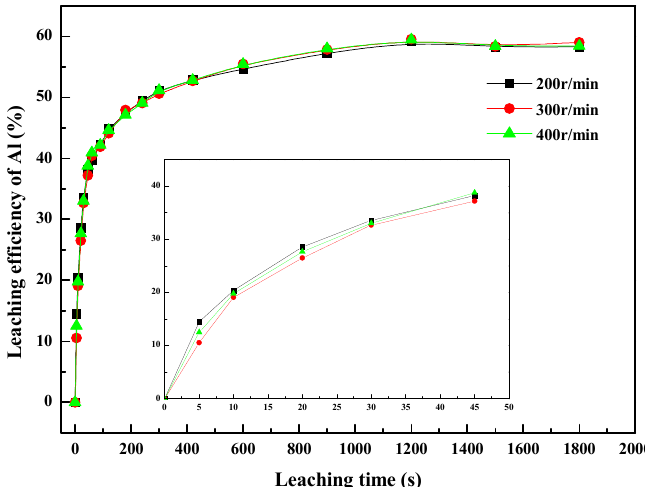
Figure 9. Leaching kinetics analysis of aluminum under different temperatures ( A : plots of 1 − (2/3) η − (1 − η ) 2/3 vs. time; B : Arrhenius plot).